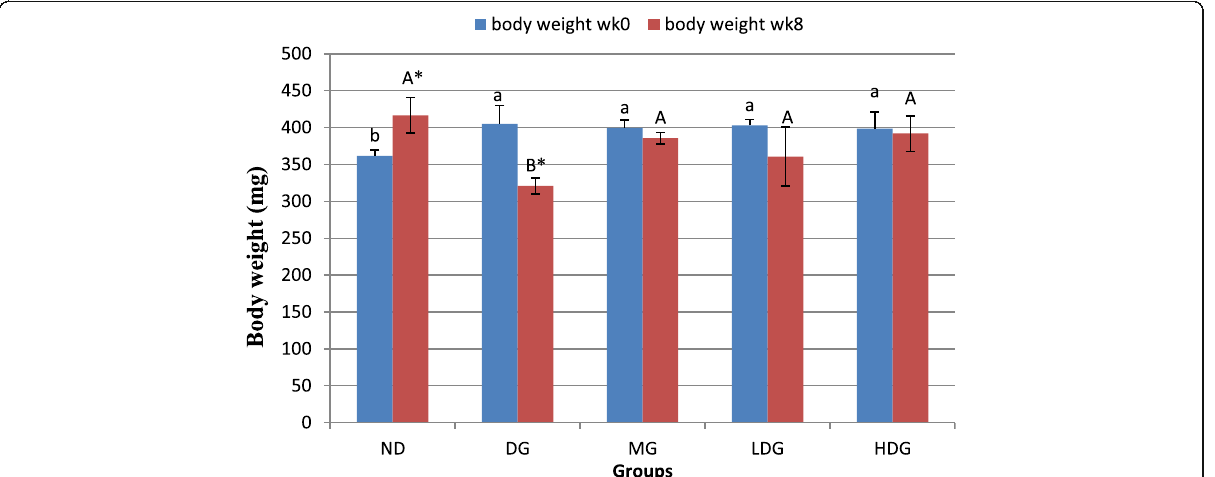
Fig. 3 Body weight of normal diet group (NG), diabetic group (DG), metformin group (MG) low dose group (LDG) and high dose group (HDG) before and after